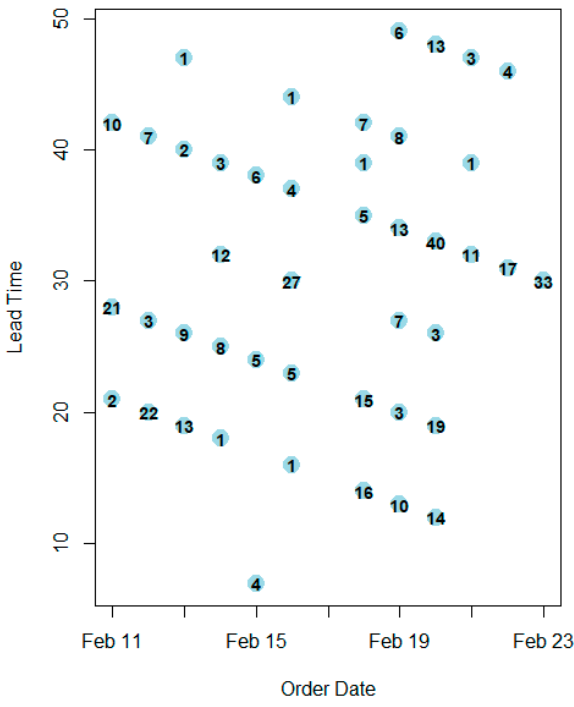
Figure 5. Lead time for orders triggered in one month. Table 1. The main results for 10 weeks plus the grand average results.